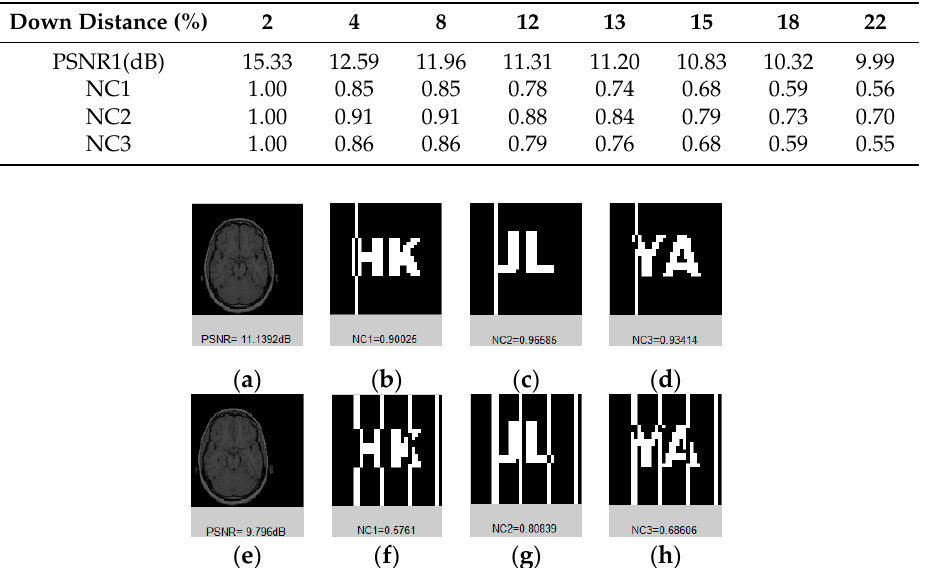
Figure 20. Under down translation attacks: (a) Down distance 12%; (b) the extracted watermark 1 under down distance 12%; (c) the extracted watermark 2 under down distance 12%; (d) the extracted watermark 3 under a down distance of 12%; (e) Down distance 22%; (f) the extracted watermark 1 under a down distance of 22%; (g) the extracted watermark 2 under a down distance of 22%; (h) the extracted watermark 3 under a down distance of 22%. Table 8. Data of down translation attacks. Down Distance (%)